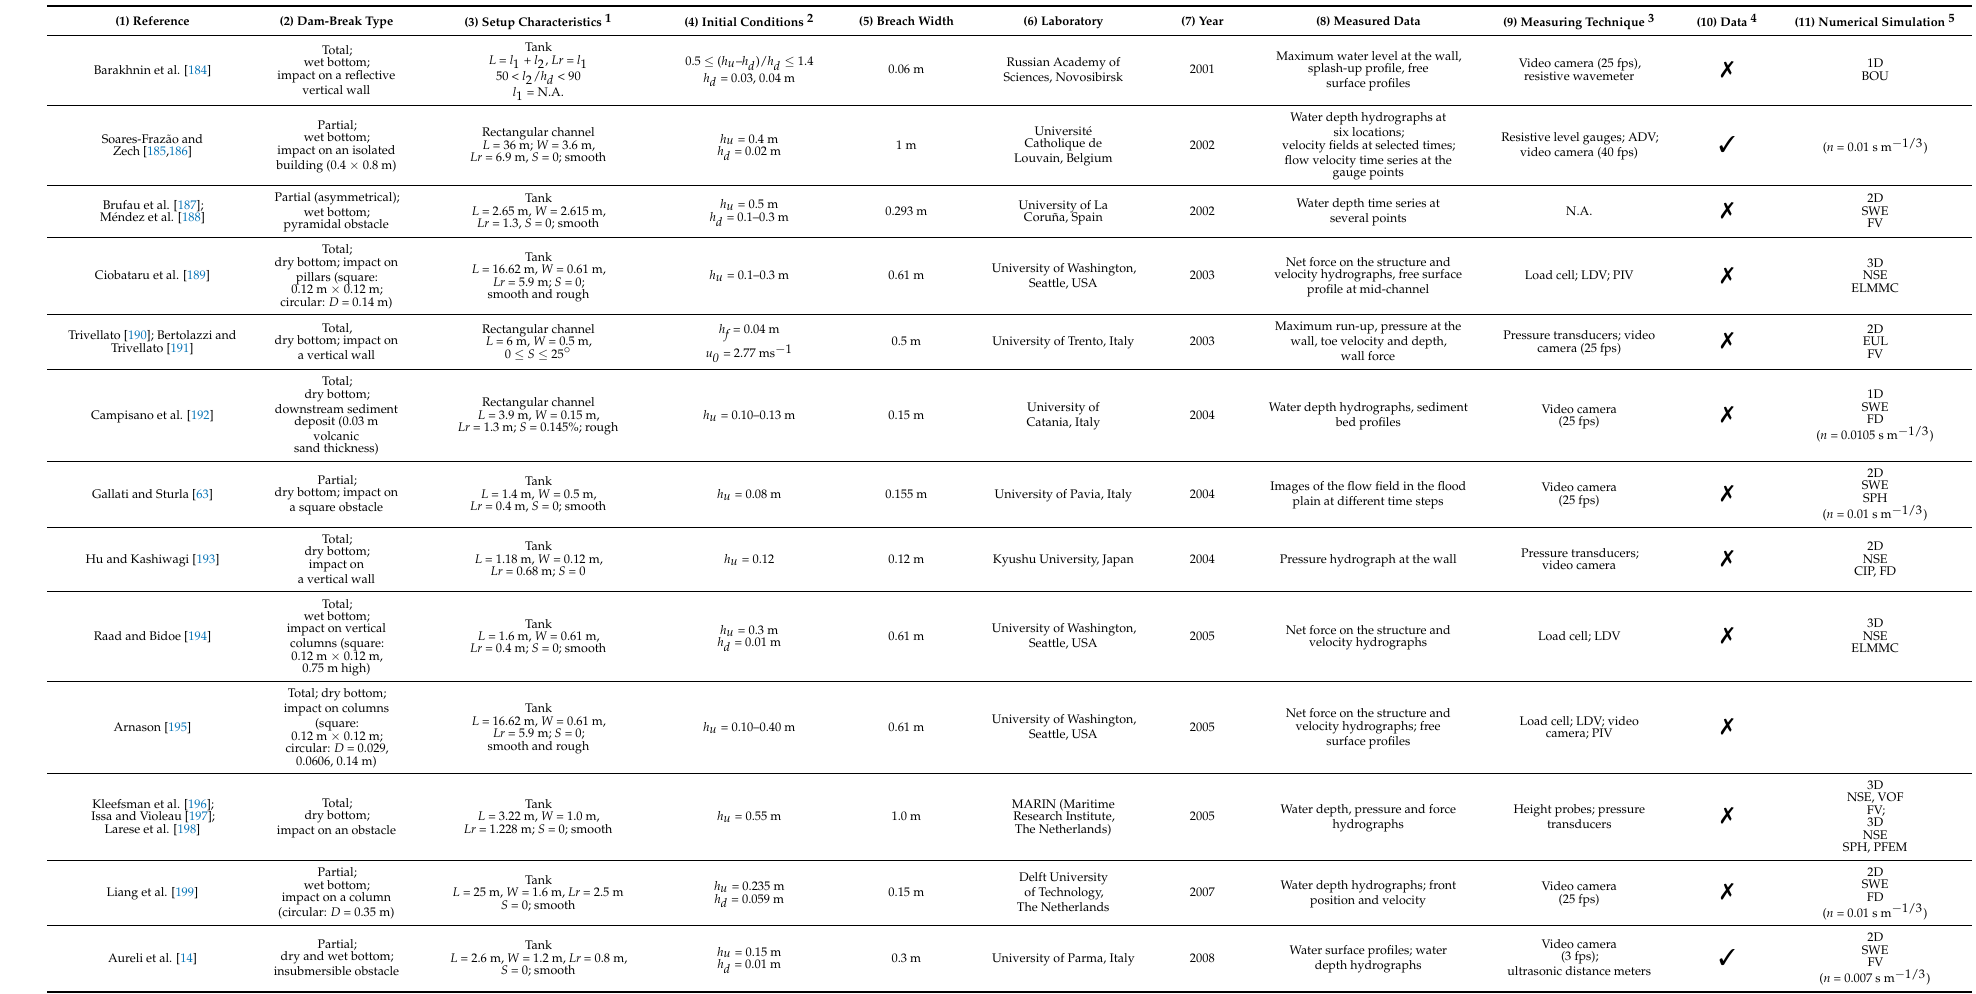
Table 1. Basic experimental investigations of fundamental dam-break wave physical characteristics.